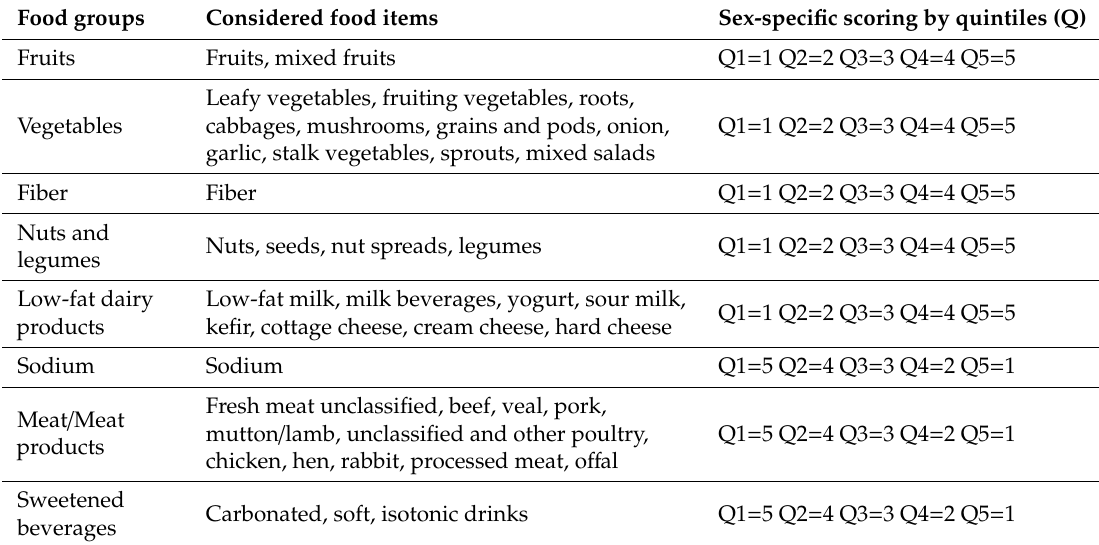
Table A2. Calculation of the DASH score.